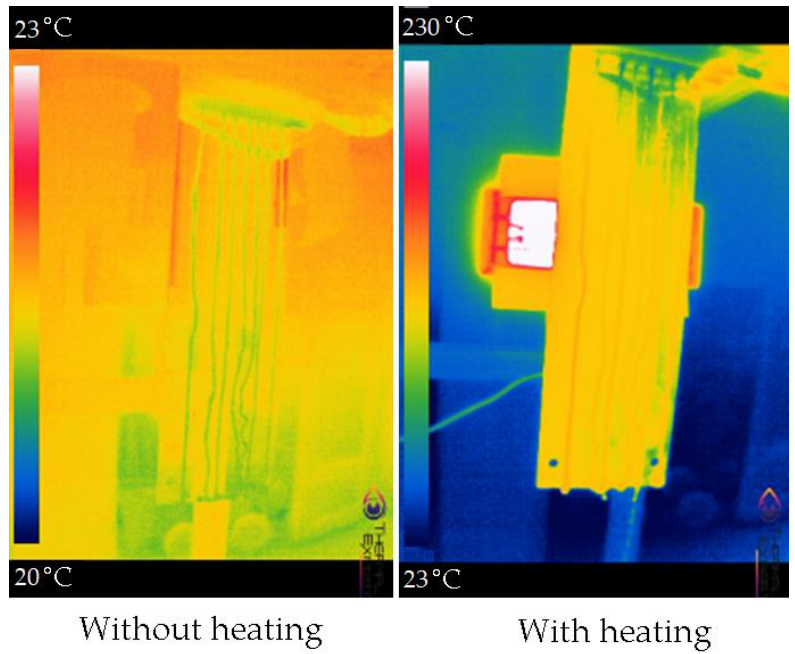
Figure 2. Thermal photos of the evaporating surface when water is supplied without heating and with heating of the surface.